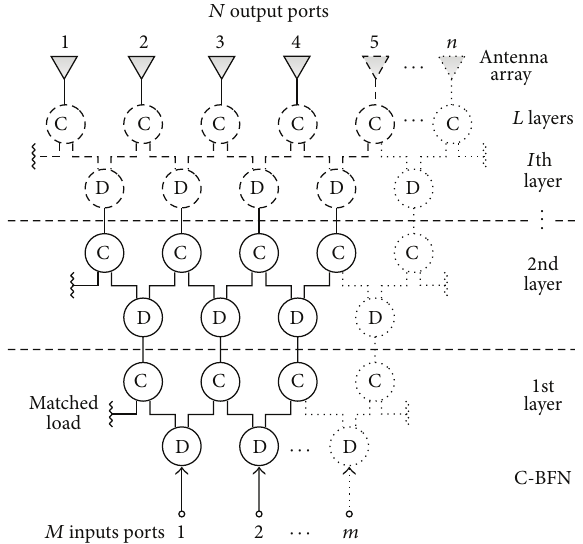
Figure 1: Schematic of a general topology of a C-BFN with power dividers (D) and power combiners (C) nodes of 𝑀 inputs, 𝑁 outputs, and 𝐿